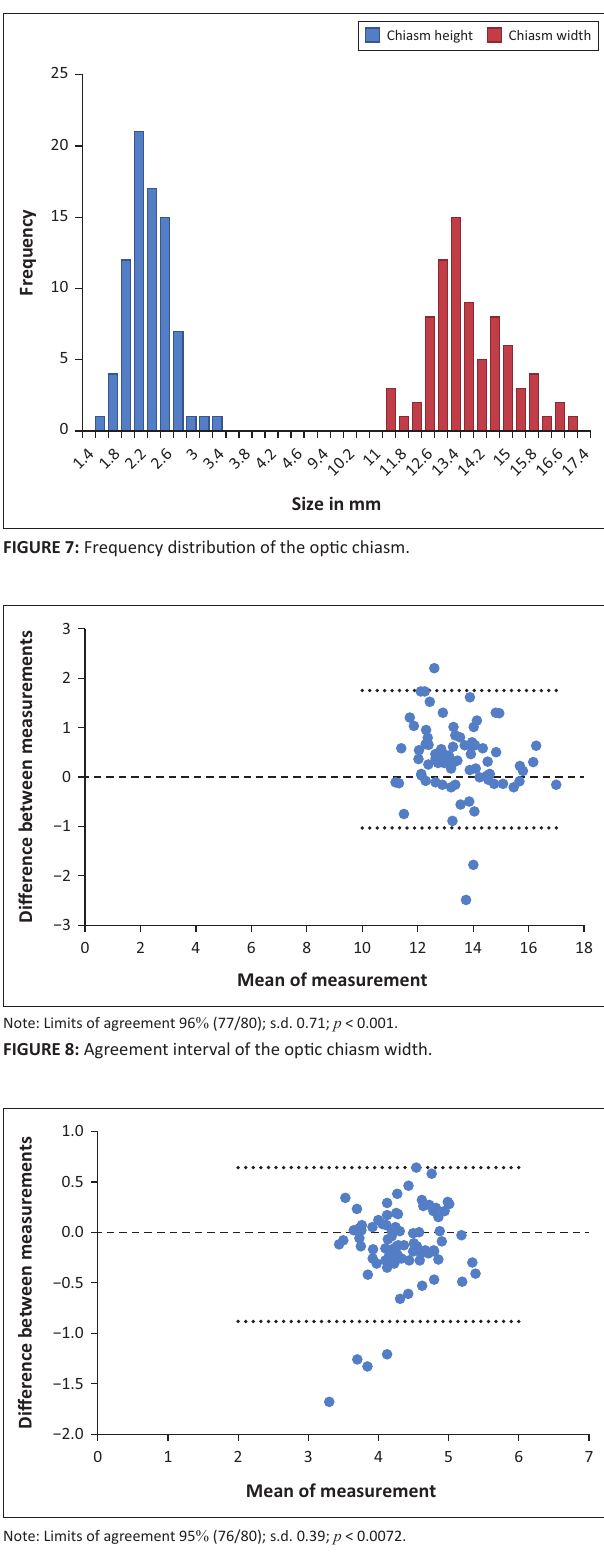
FIGURE 9: Agreement interval of the intracranial optic nerve